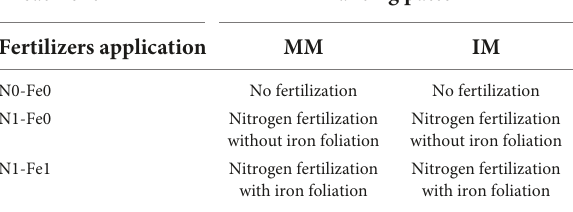
TABLE 1 The treatments combination of the